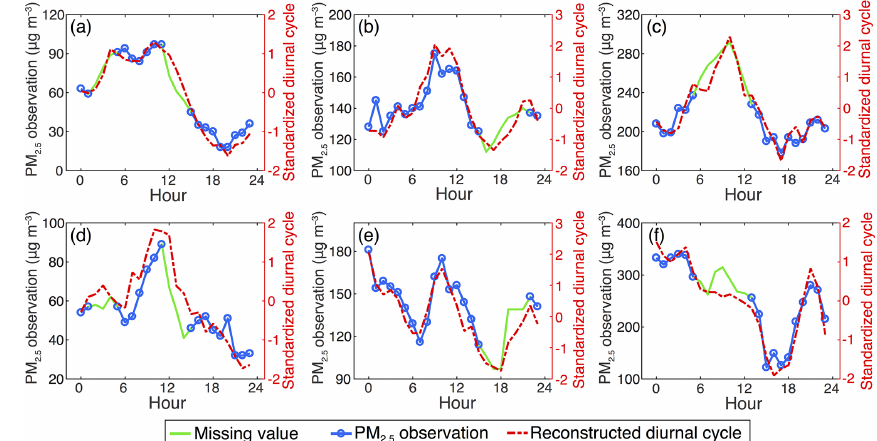
Figure 6. Comparisons of reconstructed diurnal cycles of PM 2 . 5 with their actual concentrations at distinct pollution levels. For each trial, six valid PM 2 . 5 observations were selected to simulate gapped PM 2 . 5 time series prior to the diurnal cycle reconstruction for a given day. Note that the number of neighboring stations differs between these two cases (58 for a – c and 16 for d – f ).